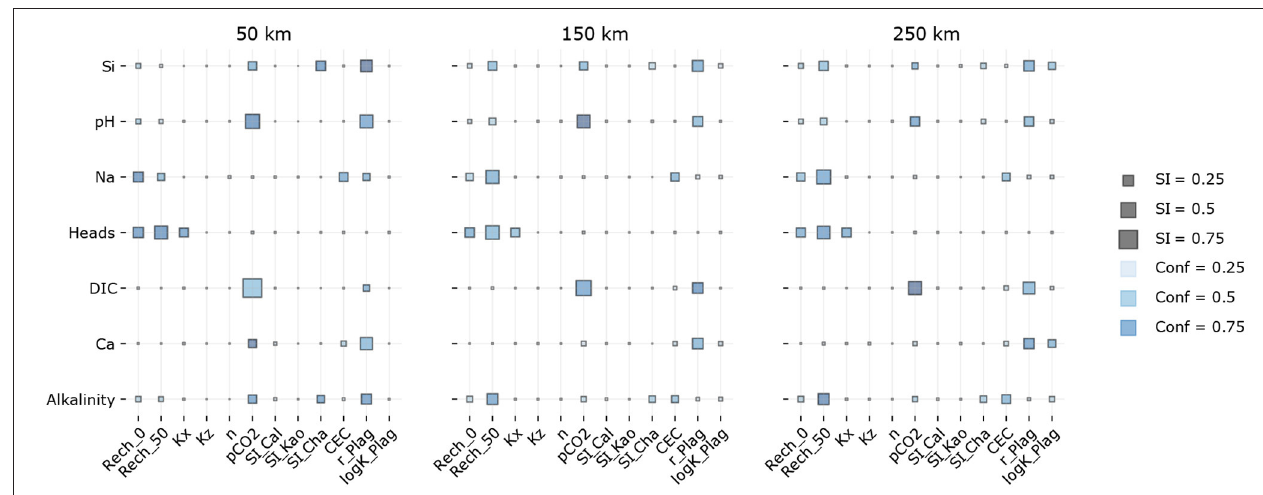
FIGURE 4 | Sensitivity indices and confidence intervals for different distances from the model edge. Inputs are on the horizontal axes, whereas outputs are on the vertical axis. Large SI for the DIC output indicates the most influential input parameters, chiefly pCO2 and r_Plag. The exact SI and Conf values are given in Appendix .